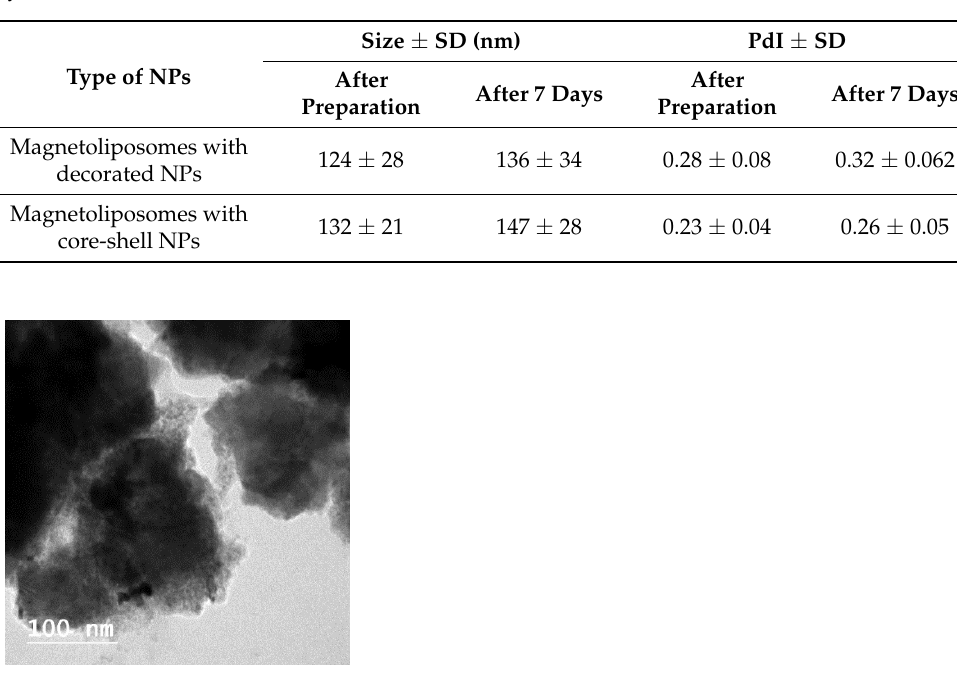
Table 5. Hydrodynamic size and polydispersity (PdI) of magnetoliposomes in PBS buffer determined by DLS. (SD: standard deviation).